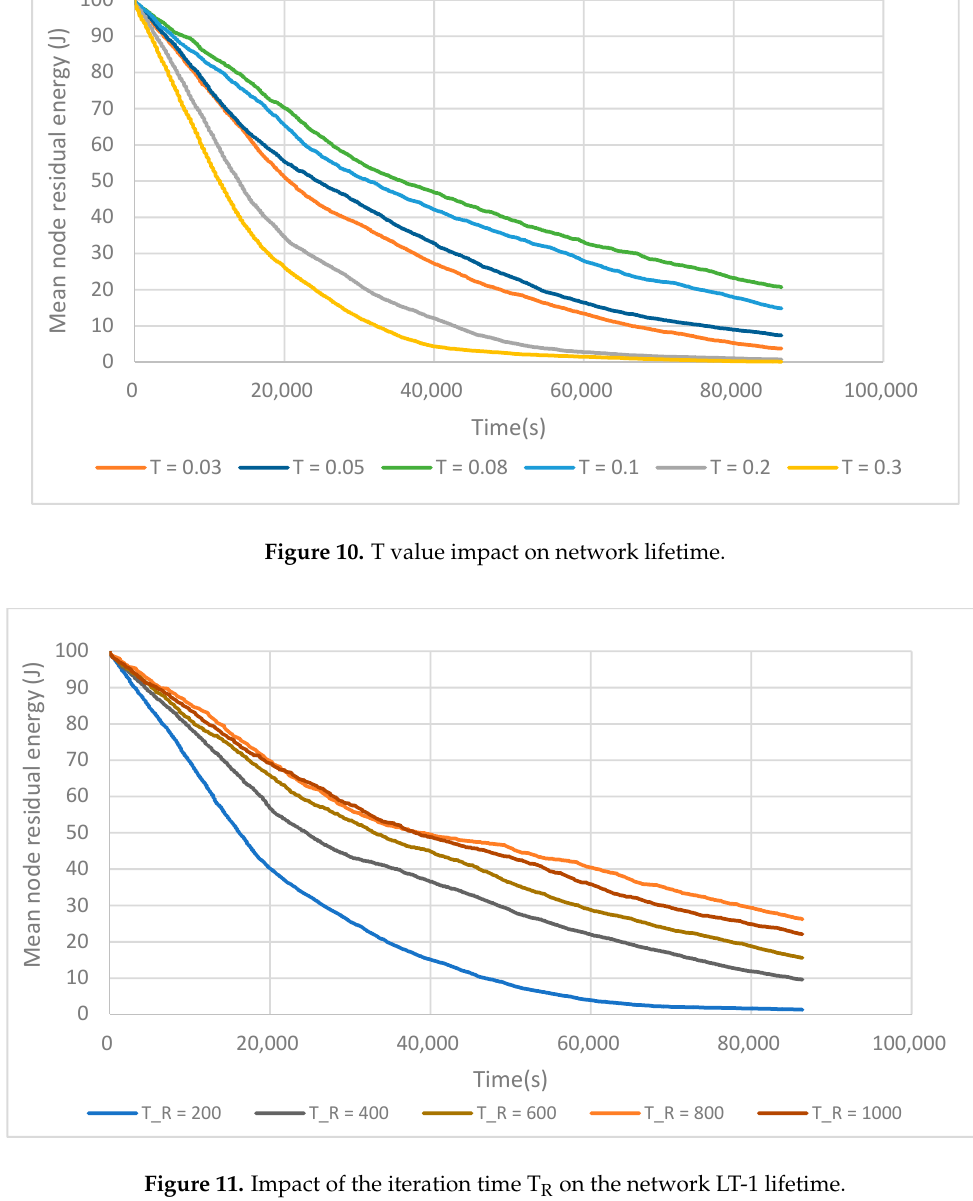
Figure 11. Impact of the iteration time T R on the network LT-1 lifetime.